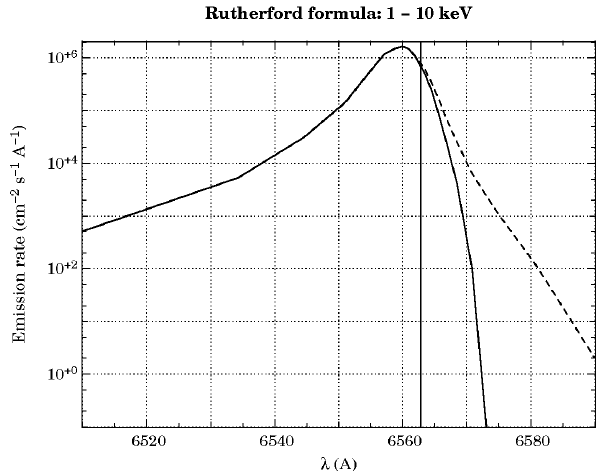
Fig. 4. H α volume emission rates in cm − 3 s − 1 ˚A − 1 computed by TRANS4 with magnetic mirroring at 107km (cyan), 114km (ma- genta), 128km (green), 138km (black), 250km (blue) and 600km (red). The effective maximum emission is encountered at around 140km, which is consistent with particles of mean energy ranging between 1 and 2keV. Only magnetic mirroring effects are consid- ered here.